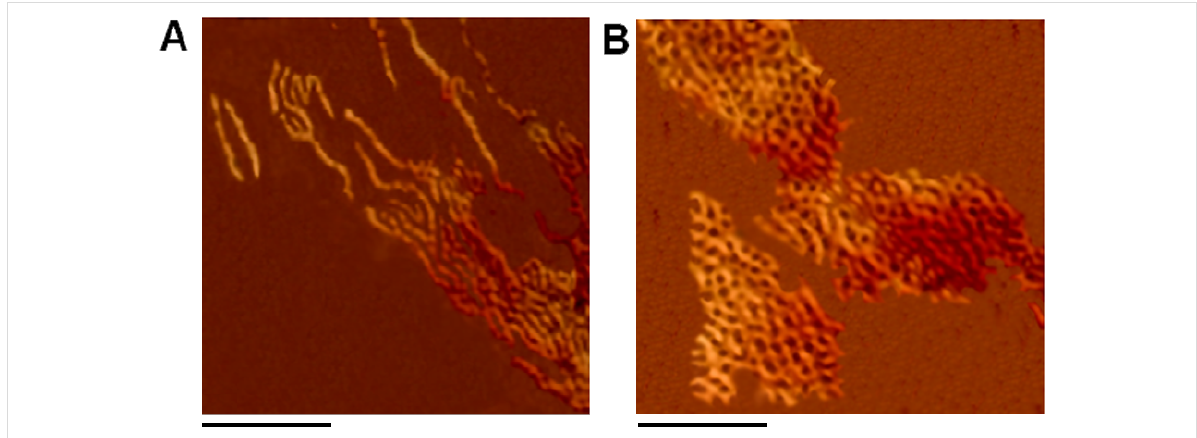
Figure 4: (A) Linear assembly of di-branched conjugates (R1) 2 –melamine and (R2) 2 –melamine. (B) Network assembly of tri-branched conjugates (R1) 3 –melamine and (R2) 3 –melamine. The black scale bar is 120